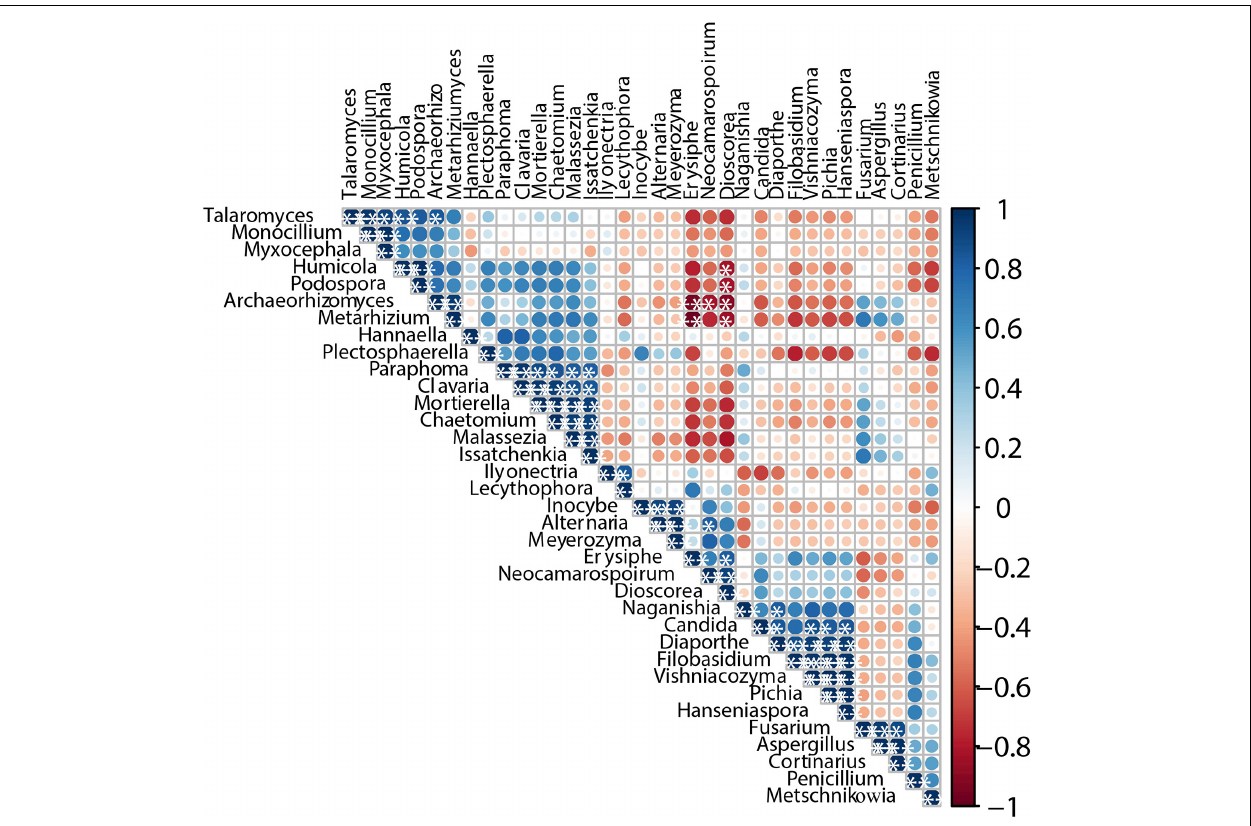
FIGURE 6 | Co-occurrence and co-exclusion relationship analysis of fungi. The figure presents a Pearson’s rank correlation matrix of the top 35 fungi genera abundance. Strong correlations are indicated by large circles, whereas weak correlations are indicated by small circles. The color of the scale bar denotes the nature of the correlation, with 1 indicating a perfect positive correlation (dark blue) and -1 indicating a perfect negative correlation (dark red). Only significant correlations (| r| > 0.7, FDR < 0.05) are shown with